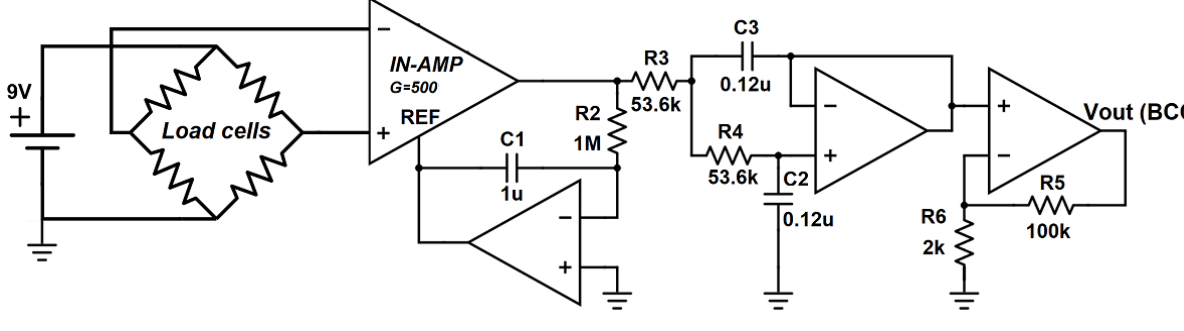
Figure 2. The analog signal-conditioning circuit. BCG: ballistocardiography; IN-AMP: instrumentation amplifier; REF: reference; Vout: output